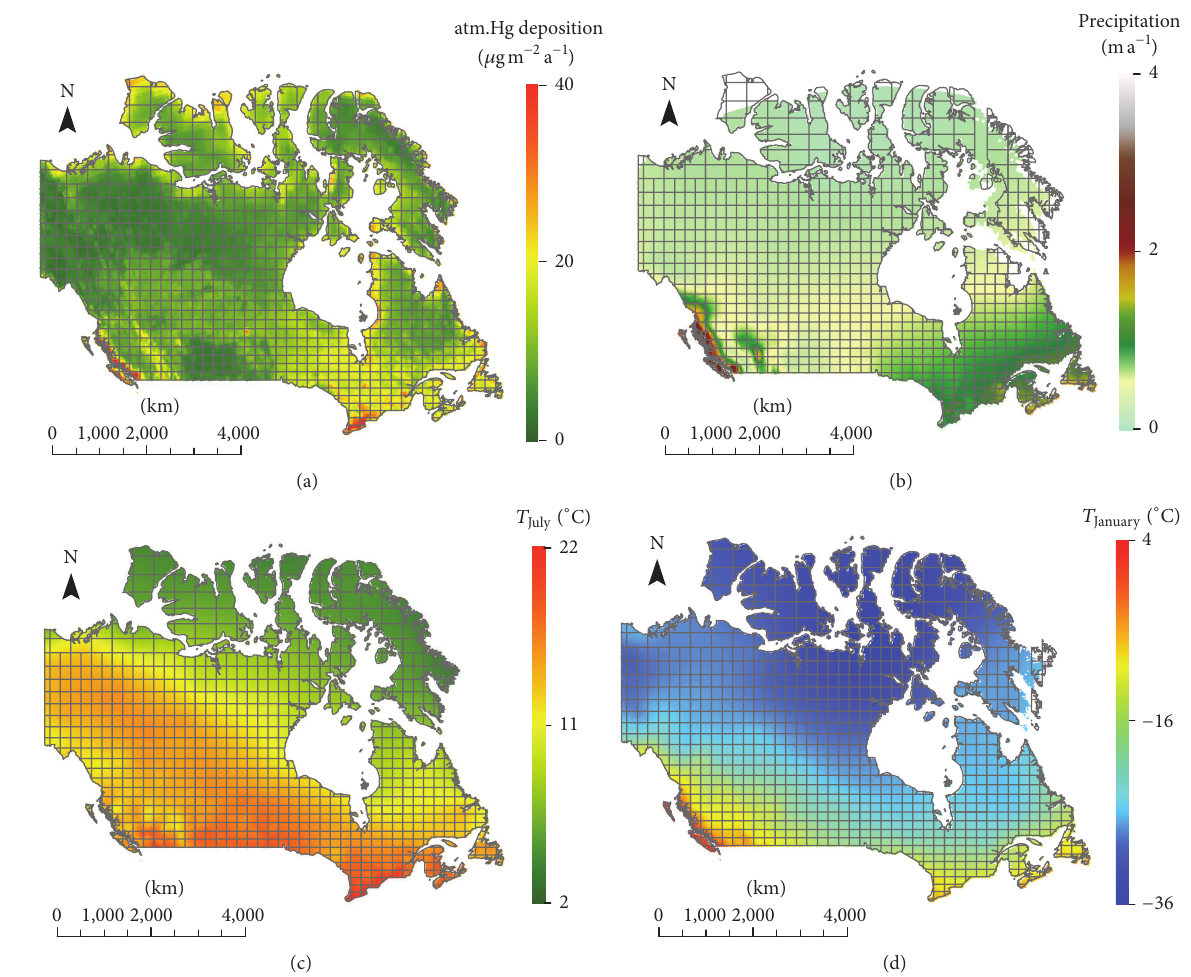
Figure 1: Canada-wide projections for atmospheric Hg deposition, mean annual precipitation, and mean annual July and January temperatures, overlaid by the 1:250,000 National Topographic System tile